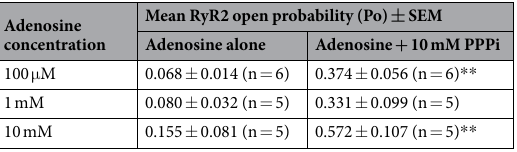
Mean binding energy of most Ligand ATP-like cluster (kcal/mol)